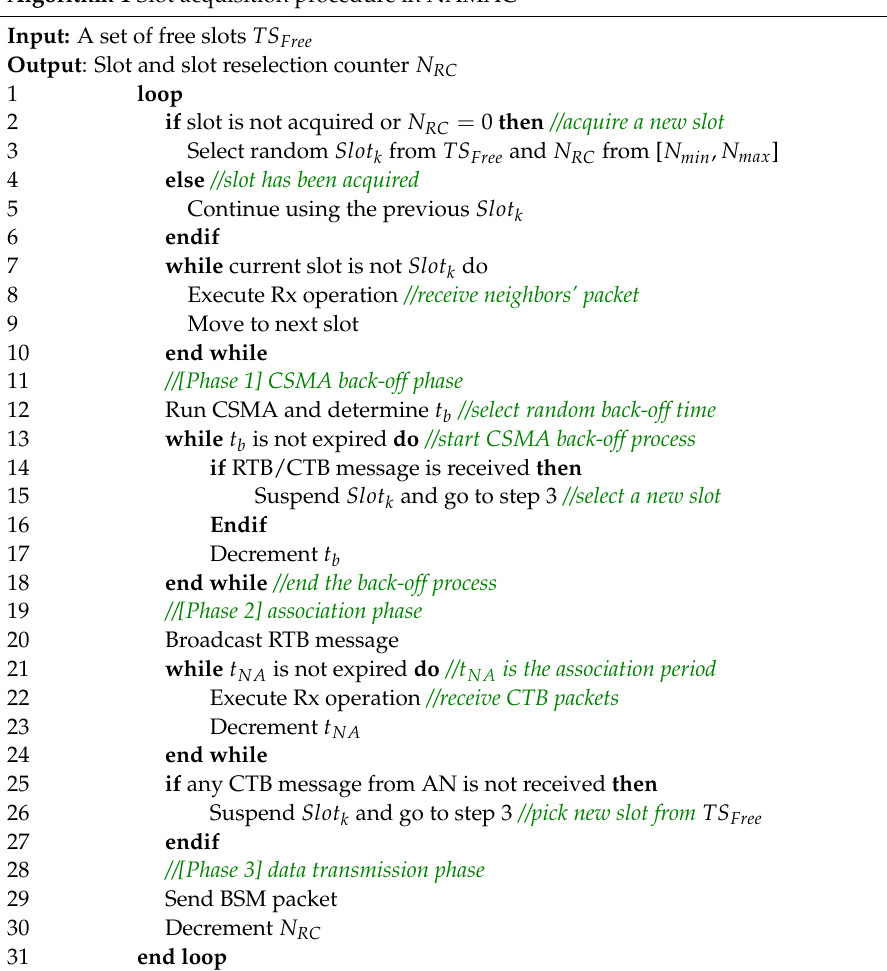
Algorithm 1 Slot acquisition procedure in